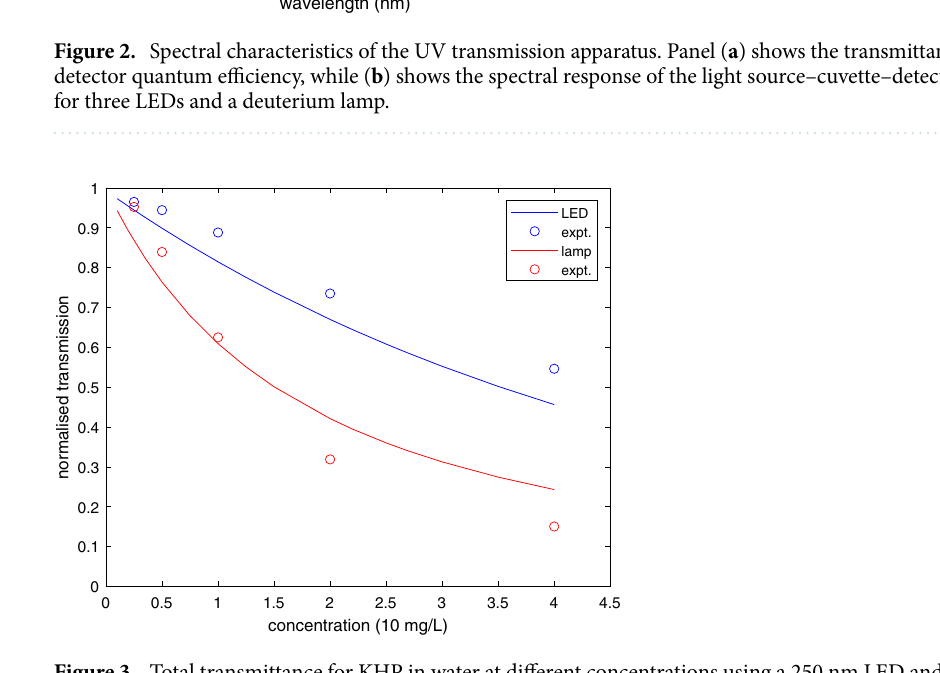
Figure 3. Total transmittance for KHP in water at different concentrations using a 250 nm LED and a deuterium lamp. Solid lines are from the model. Experimental error bars in both transmission and concentration are within the size of the